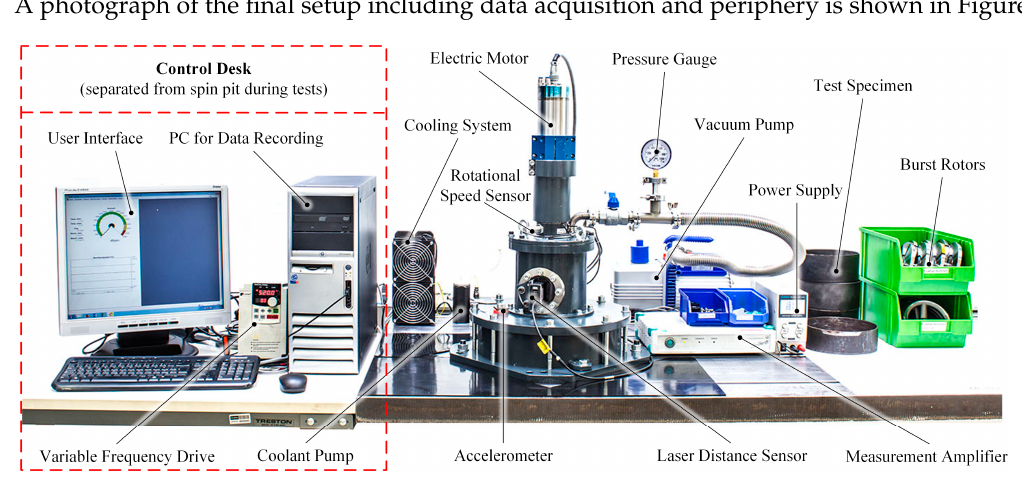
Figure 9. Low-cost spin pit and major components including periphery. Please note that the control desk (left) is moved away from the test rig when burst tests are conducted.